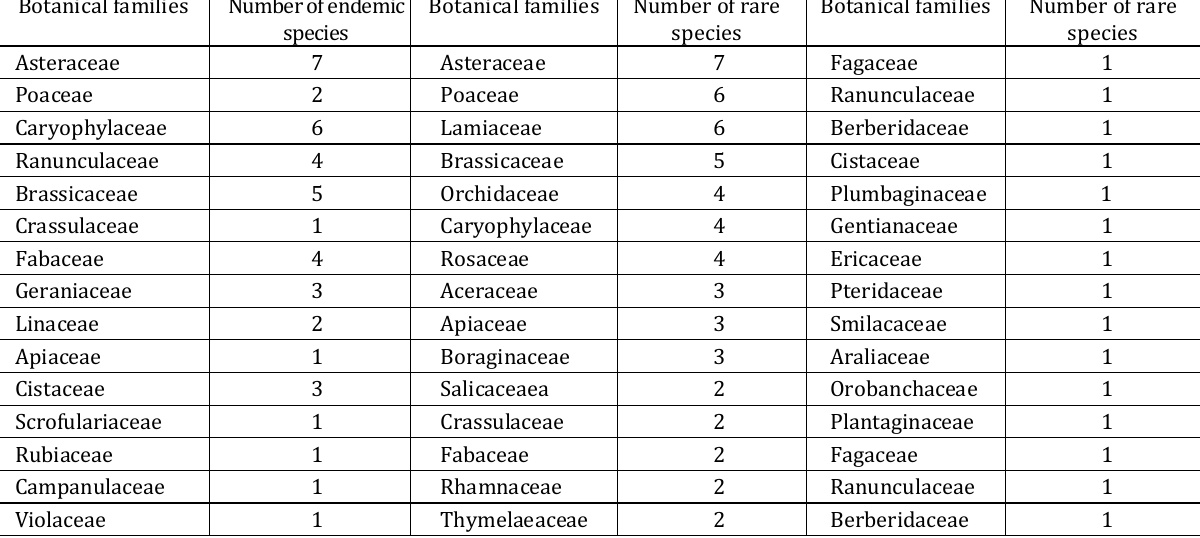
Table 3. Number of endemic and rare species per family within the Guerrouche